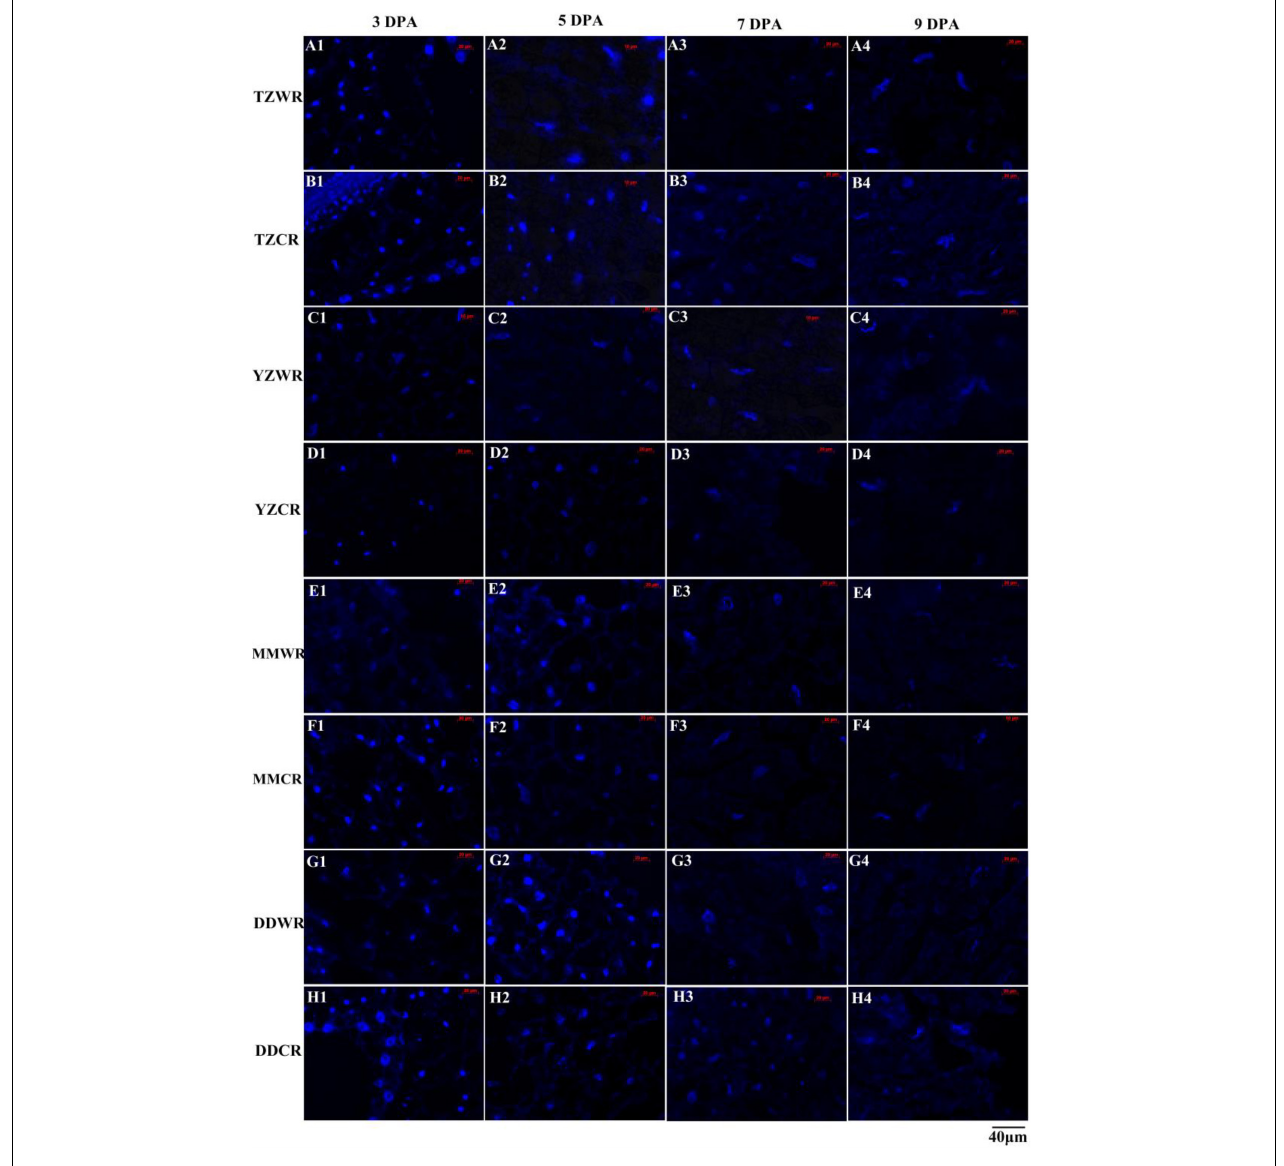
FIGURE 1 | 4 (cid:48) ,6-Diamidino-2-phenylindole staining of endosperm nucleus in weedy and cultivated rice. (A1–A4) : weedy rice from Taizhou, TZWR; (B1–B4) : cultivated rice from Taizhou, TZCR; (C1–C4) : weedy rice from Yangzhou, YZWR; (D1–D4) : cultivated rice from Yangzhou, YZCR; (E1–E4) : weedy rice from Maoming, MMWR; (F1–F4) : cultivated rice from Maoming, MMCR; (G1–G4) : weedy rice from Dandong, DDWR; (H1–H4) : cultivated rice from Dandong,